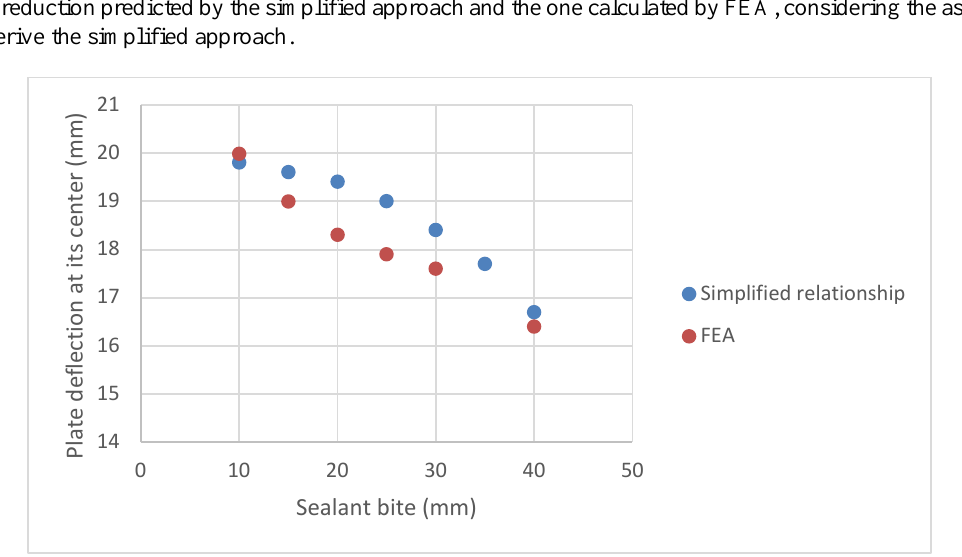
Fig. 9: Comparison between plate deflection at the center using the simplified method including joint effect and the results of FEA modeling. The glass plate deflection at its center has been combined with the method proposed in (Descamps 2017) to calculate the maximum strain of the joint in the middle of the longer plate side b. These results are compared to the results of 3D FEA simulation (figure 10). First, we observe a sharp decrease followed by a minimum before the joint strain strain when having large sealant bites. We observe that both FEA and the simplified method (with the joint